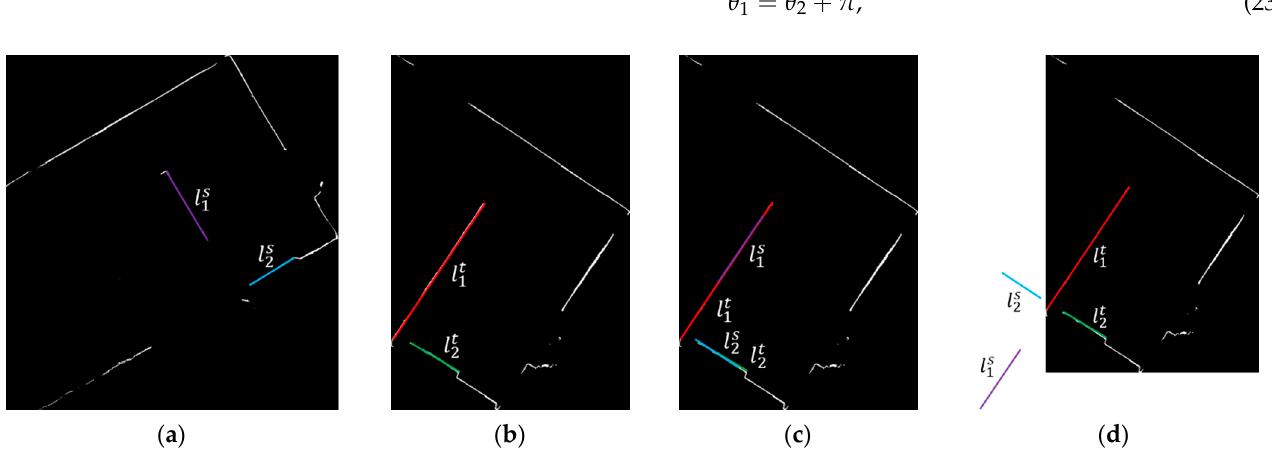
Figure 4. Two solutions for pair line matching. ( a ) Two lines in the source ortho-projected image, ( b ) two corresponding lines in the target ortho-projected image, ( c ) matching solution 1, ( d ) matching solution 2.